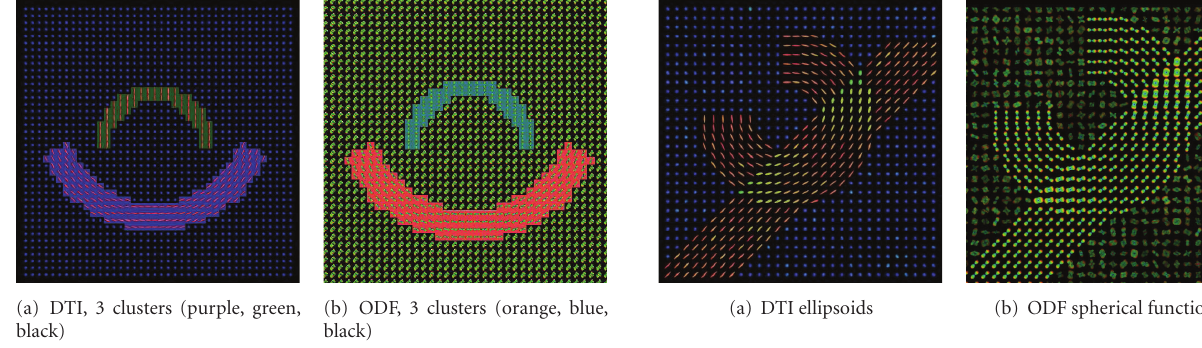
Figure 3: Synthetic image without fiber crossings. The results for the DT and ODF images are equivalent. The colors behind the DTs and ODFs indicate the clusters.